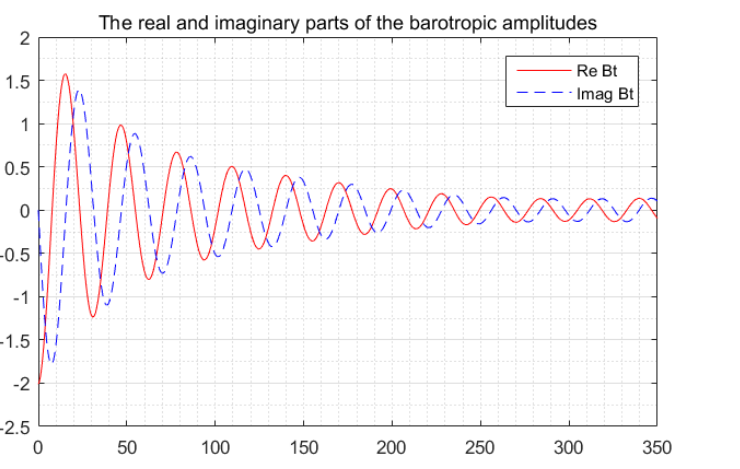
Figure 1. Asymptotically small H solutions developed on long time scales: T = Ht . Real and imaginary parts of barotropic Rossby wave amplitude. The results in each case match the analytical solutions of (36)–(38). The calculations are performed for µ = 0.015, F = β = 20, H = 0.05, and k = l = π .